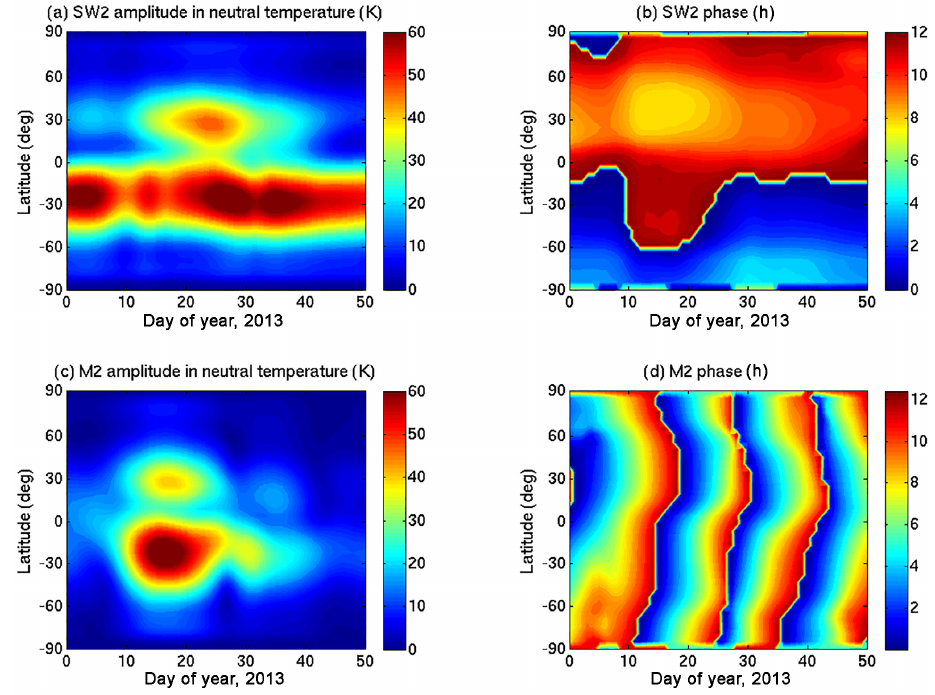
Figure 9. Same as Fig. 7, except for the 2012–2013 SSW event (simulations from Maute et al.,